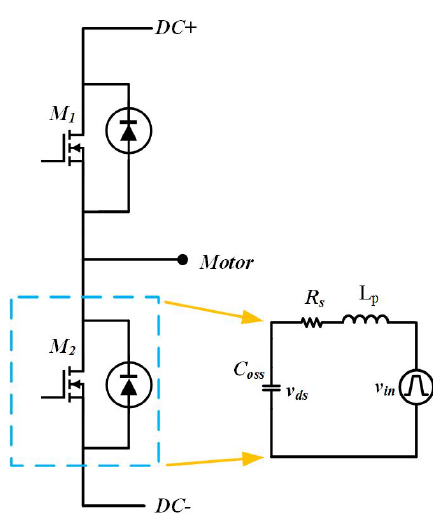
Figure 8. Simplified modeling of switching behavior of SiC